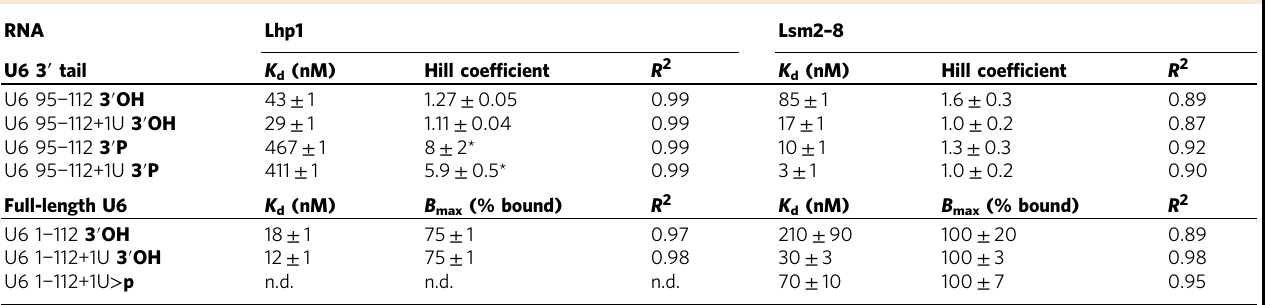
Table 2 Lsm2 – 8 and Lhp1 binding parameters for U6 RNA with different 3 ′ ends